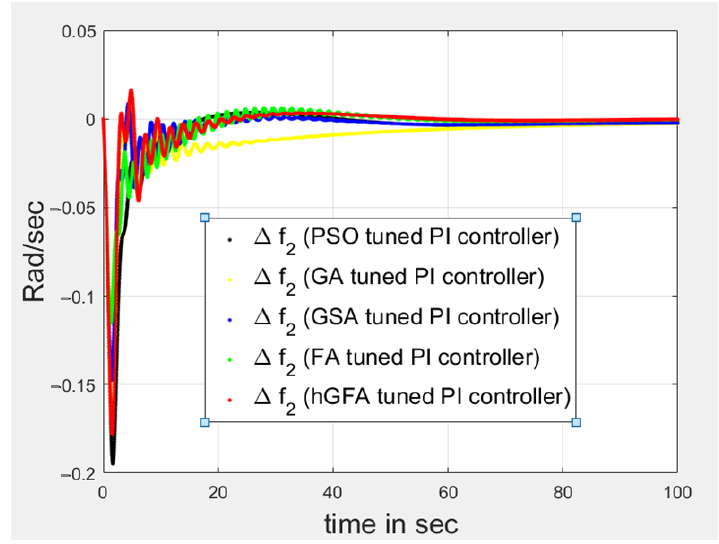
Figure 6. Perturbation in load frequency response in area-2 of HTPS for case study-II.